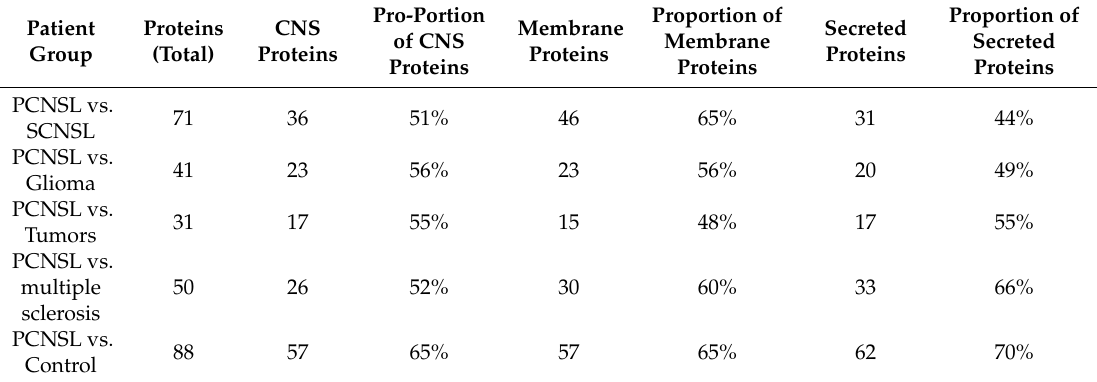
Table 3. Assignment of di ff erentially abundant proteins to tissue origin and protein